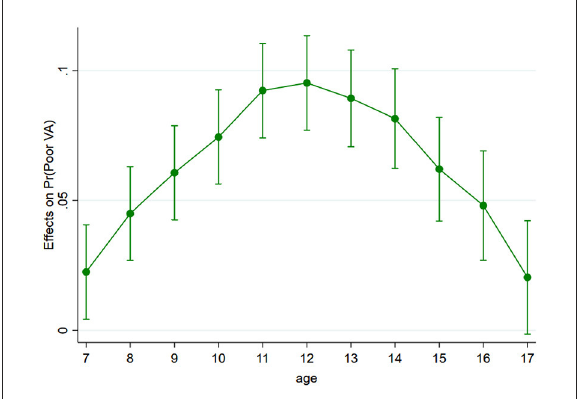
FIGURE1 The effects of age on poor visual acuity among children and adolescents.